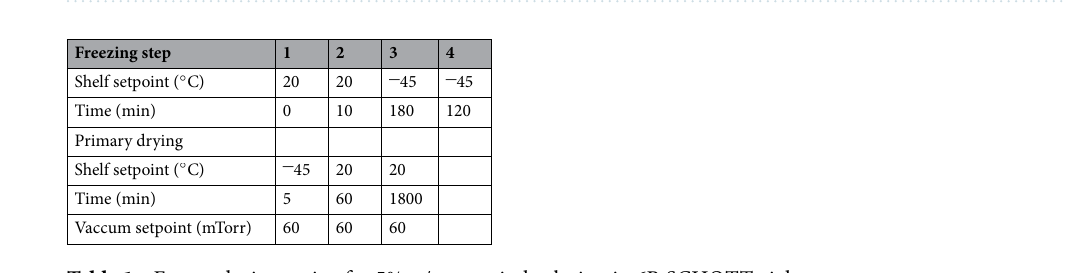
Table 1. Freeze-drying recipe for 5% w/v mannitol solution in 6R SCHOTT